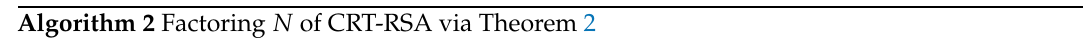
Algorithm 2 Factoring N of CRT-RSA via Theorem